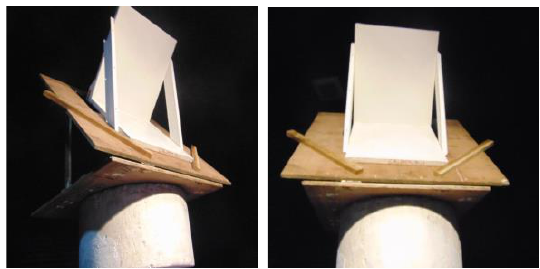
Figure 3: Corner Reflector under test at CAR Facility